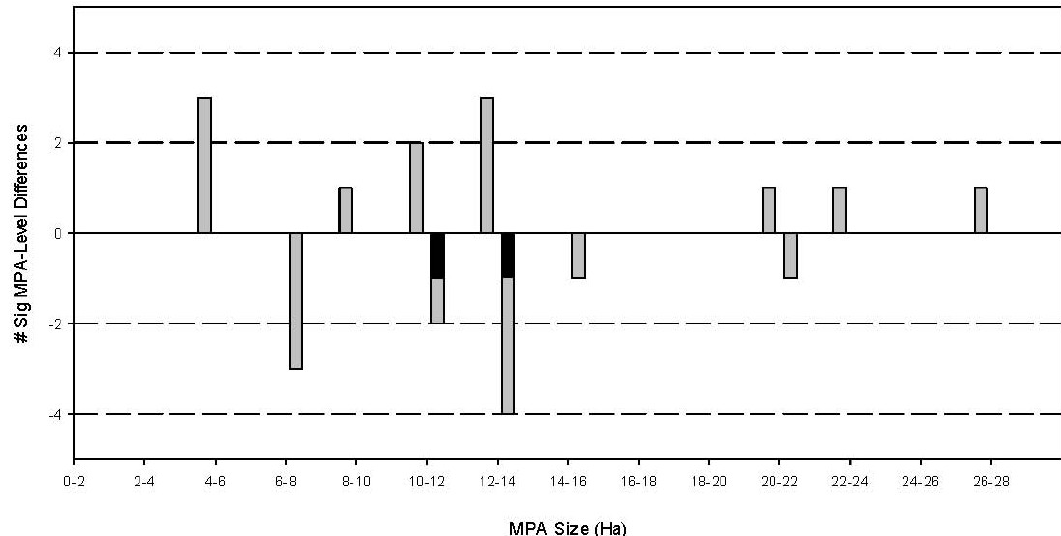
Figure 3. The relationship between the occurrence of a significant body size frequency distribution and MPA size. Grey bars above y = 0 represent the number of MPAs of a given size that demonstrated a significant shift in body size distribution compared to fished reefs. Grey bars below y = 0 represent the number of MPAs of a given size that did not show a significant difference in body size distributions. Black bars below the x-axis represent MPAs that demonstrated a significant shift in body size distributions towards larger body sizes of fishes in fished reefs compared to fishes within MPAs. The results of a contingency table analysis revealed no significant association between MPA size and body